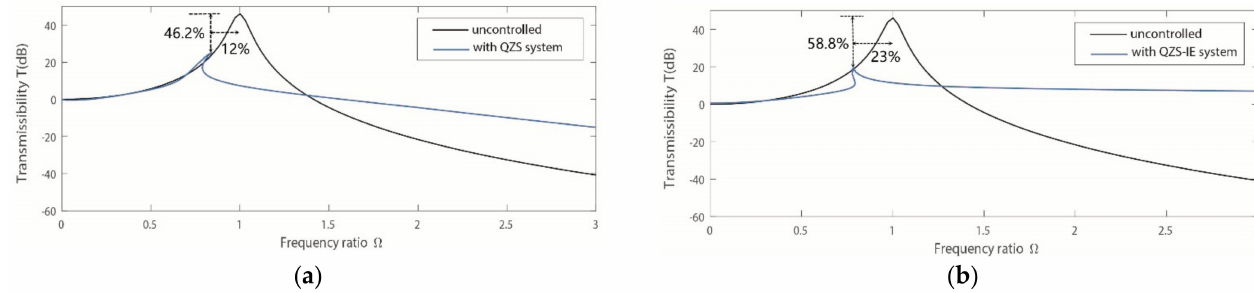
Figure 12. The vibration suppression effects of the seat suspension system ( u 0 = 0.9): ( a ) The displacement transmissibility of the QZS system without inerter elements; ( b ) the displacement transmissibility of the QZS-IE system.